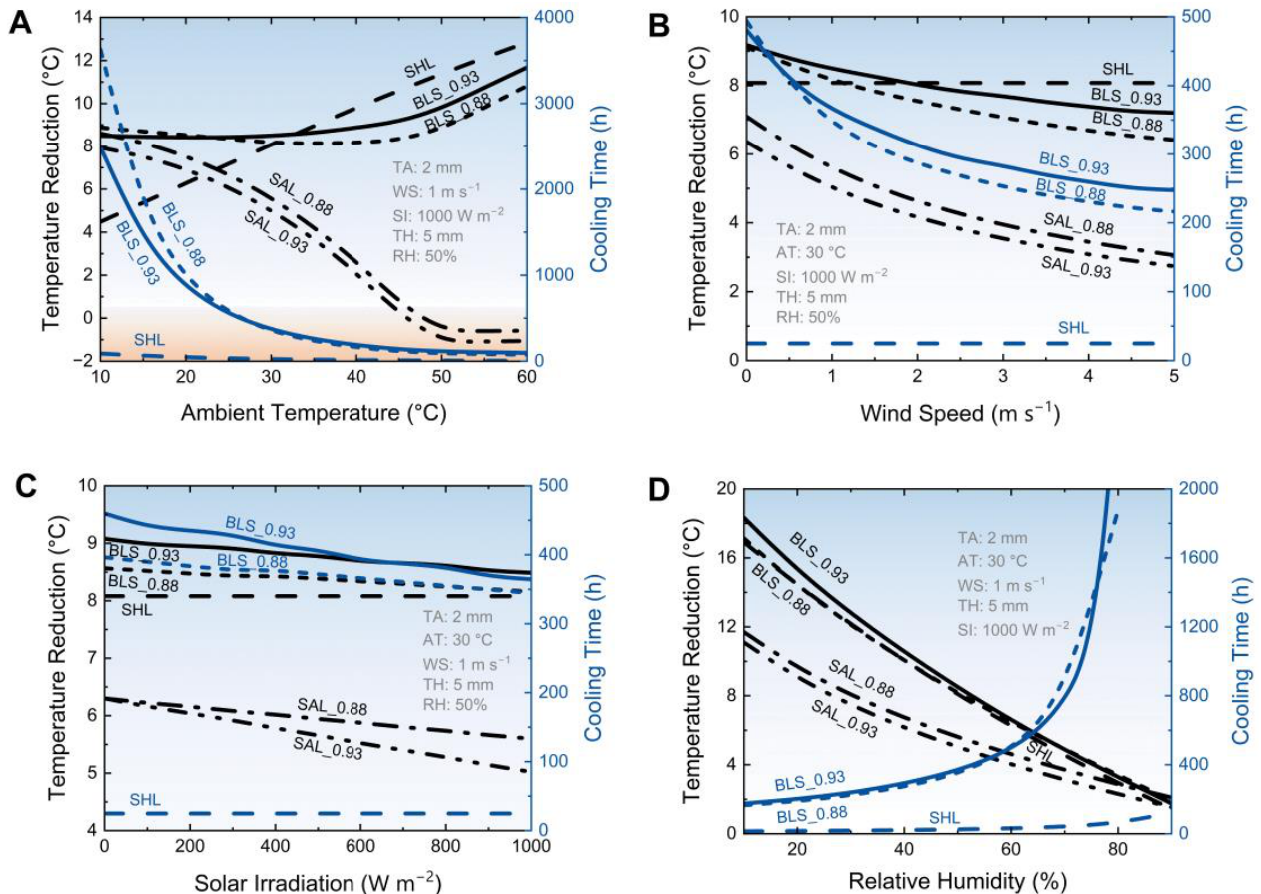
Figure 7. The effect of weather conditions on cooling performance. Simulated temperature reduction and cooling time span with different ambient temperatures ( A ), wind speeds ( B ), solar irradiation ( C ), and relative humidity ( D ).